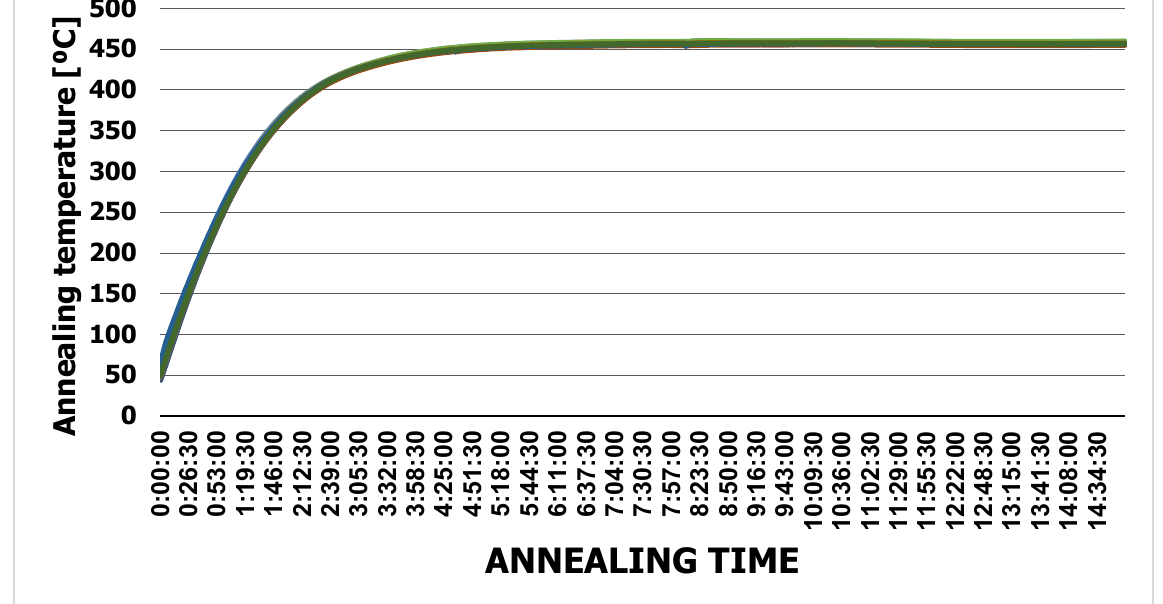
Figure 14. Annealed die temperature graph without housing.